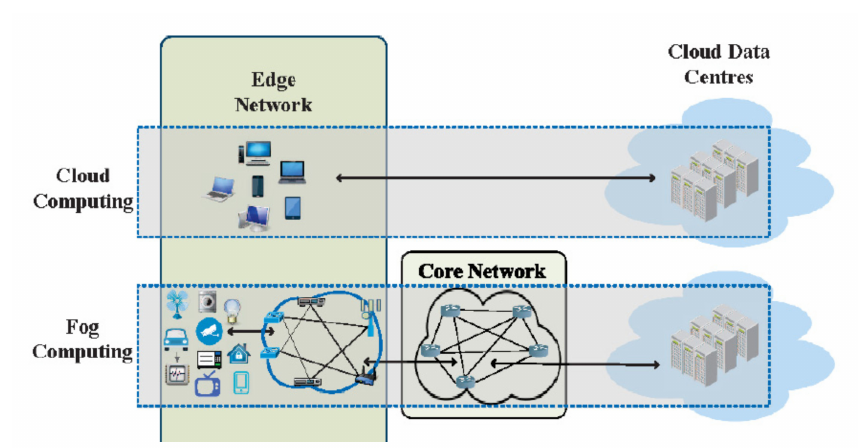
Figure 2. WSN to Fog integration.